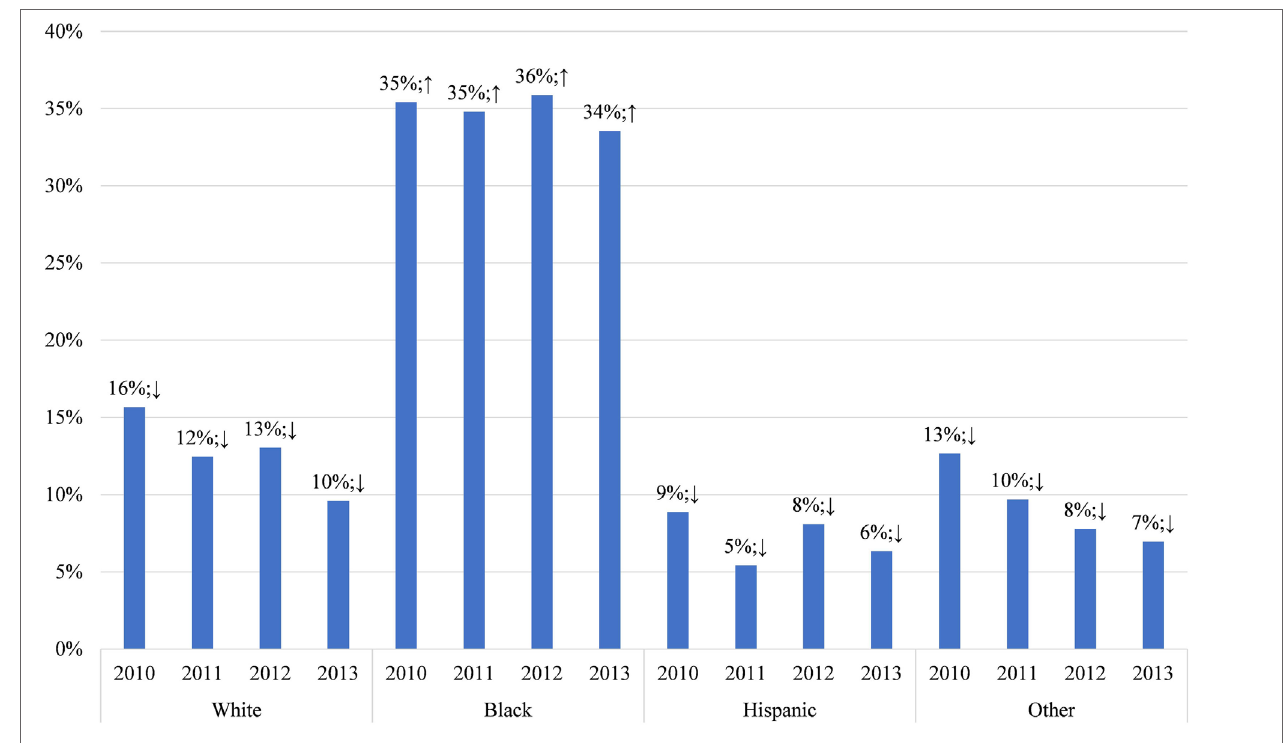
FigUre 3 | Proportion living in zip codes with median household incomes in bottom quartile, by race, in Maryland